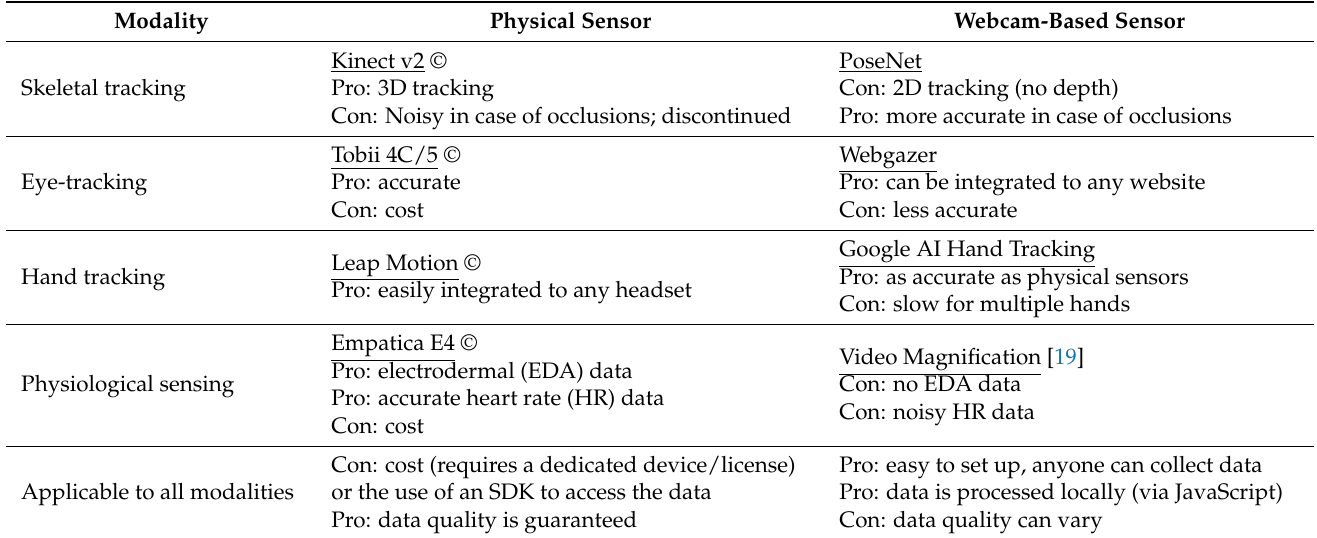
Table 1. Comparison of Physical and Webcam-based sensors across different modalities. Exemplar tools are underlined. Pros and cons are described below each